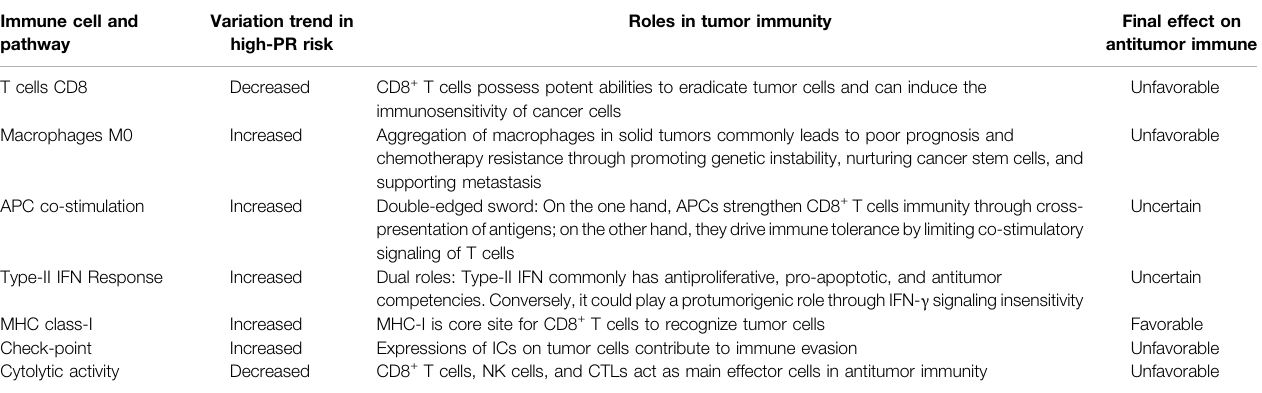
TABLE 2 | Associations between PR risk score and TIM.